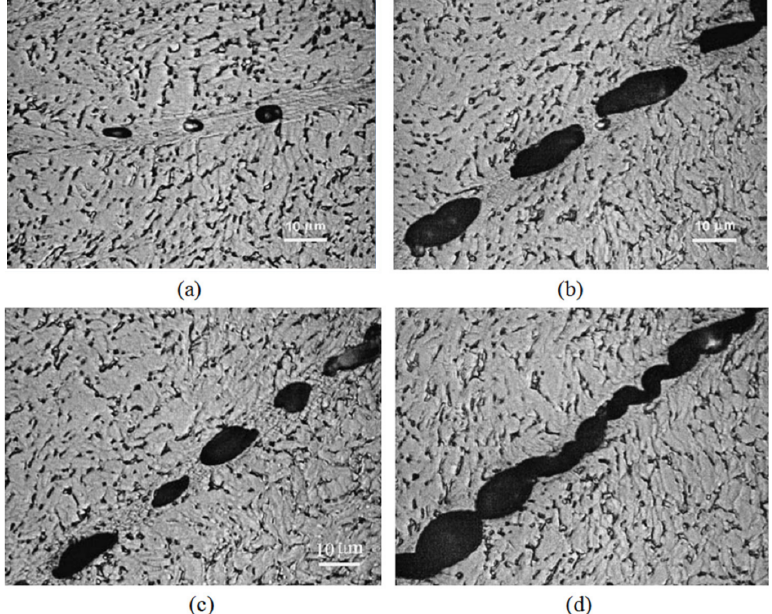
Figure 11. Void nucleation and growth inside a shear band in experimental results of Ti6Al4V through the radial collapse of a thick-walled cylinder under high-strain-rate deformation ( ≈ 10 4 s − 1 ): ( a ) Nucleation of voids within a shear band; ( b ) growth of voids; ( c ) elongation and rotation of voids; and ( d ) coalescence (with permission of